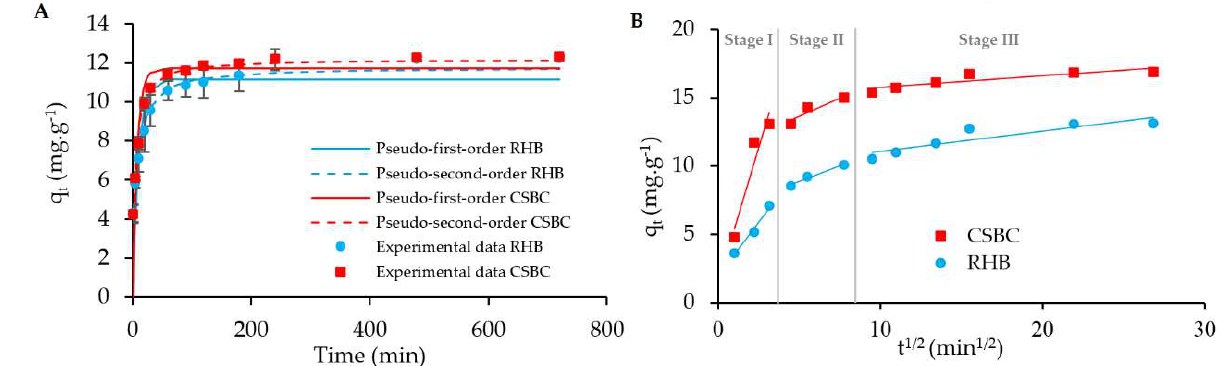
Figure 7. Fitting of PFO and PSO kinetic ( A ) and IPD ( B ) models for MO adsorption on CSBC and RHB. Table 2. Fitting results of different kinetics for MO Adsorption by RHB and